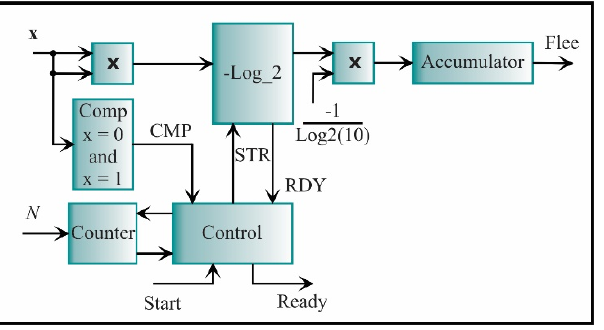
Figure 19. The architecture of the processing core for computing the log energy entropy.